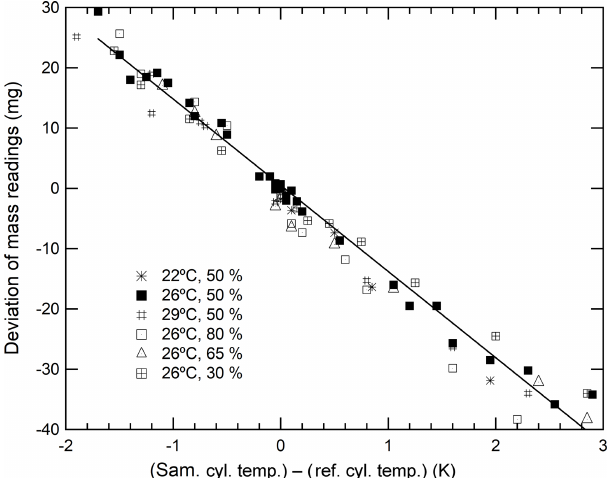
Figure 2. Changes in the mass readings observed for sample cylin- ders plotted against temperature differences obtained under various conditions (a temperature range from 22 to 29 ◦ C and a humidity range from 30% to 80%.)